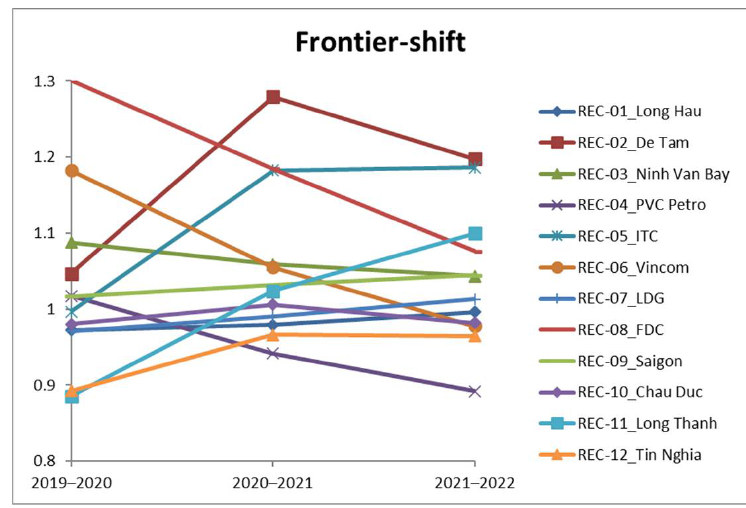
Figure 7. Technological efficiency change (2019–2022).